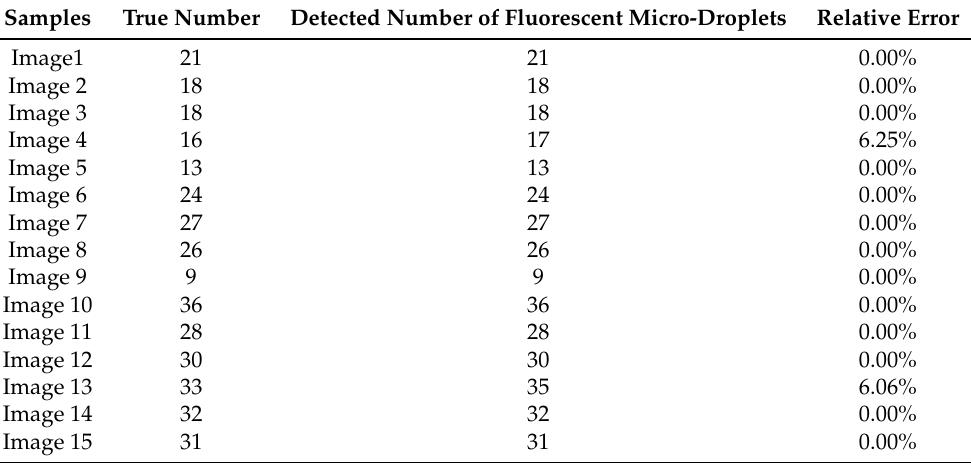
Table 3. Comparison evaluation of the number of detected fluorescent micro-droplets.